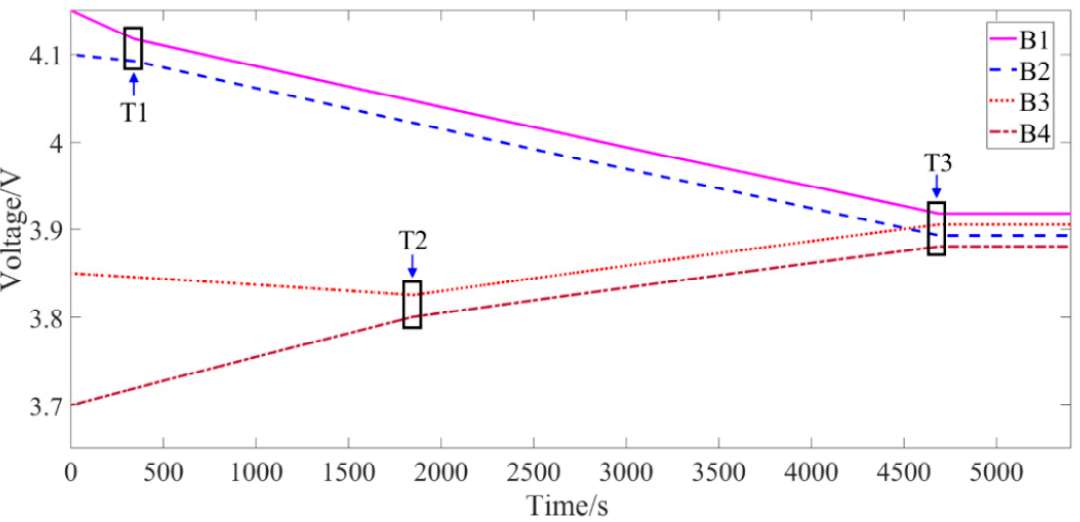
Figure 10. Static state simulation results.